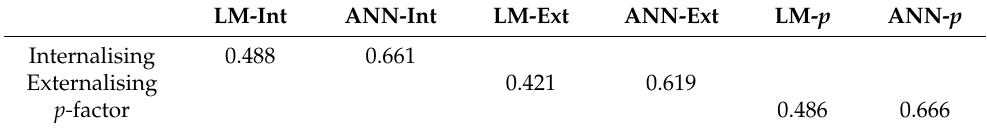
Table 4. Correlations Between Predicted and Actual Higher-Level Psychopathology